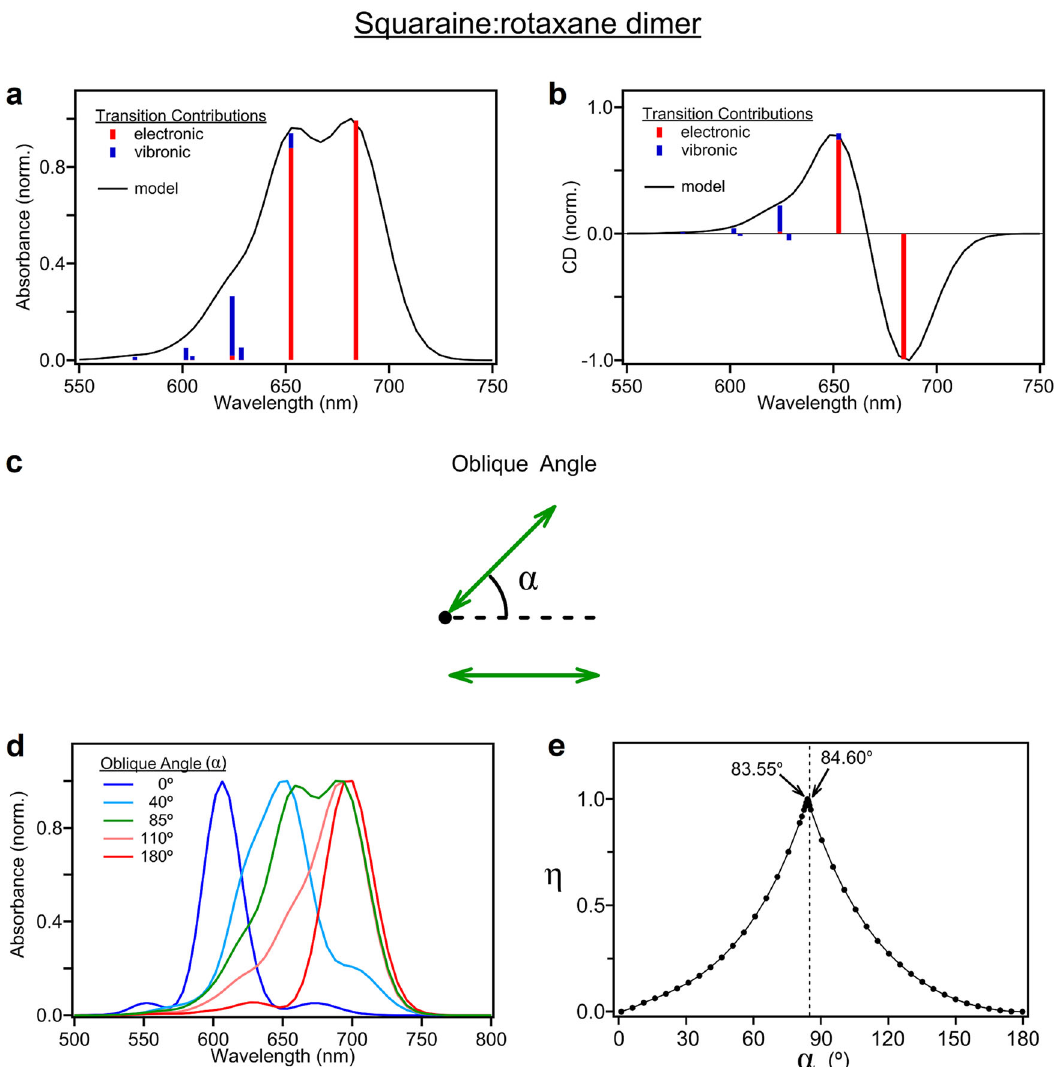
Fig. 4 Relative electronic and vibronic contributions to optical spectra and sensitivity of the absorption spectrum to oblique angle. a , b Electronic and vibronic contributions to the steady-state absorption and CD spectra of the SR dimer structure. c Schematic showing the oblique angle between two molecules in a dimer that was varied to produce the absorption spectra in d . The TDMs of the molecules are represented with arrows and are assumed to be oriented along the long axis of the molecule. The oblique angle is varied by rotating the TDM around the point indicated by the black circle. The dashed line corresponds to a relative orientation between molecules where α = 0°. d Simulated absorption spectra as a function of oblique angle, α . Dipoles are assumed to be coplanar with a fi xed distance of nearest approach, modeled using parameters determined from the experimental data of the SR monomer and dimer solutions. e Plot of the ideality factor, η , as a function of α . When η = 1, the electronic bands are of equal intensity; when η = 1, the electronic bands exhibit their maximum intensity difference. The dashed black line represents the α output from the KRM modeling for the SR